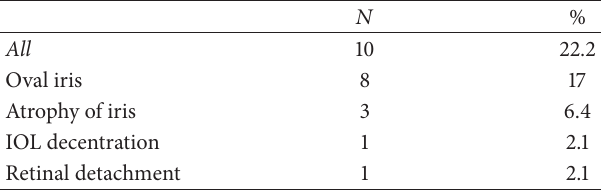
Table 3: Postoperative complications and abnormalities. 𝑁 % All 10 22.2 Oval iris 8 17 Atrophy of iris 3 6.4 IOL decentration 1 2.1 Retinal detachment 1